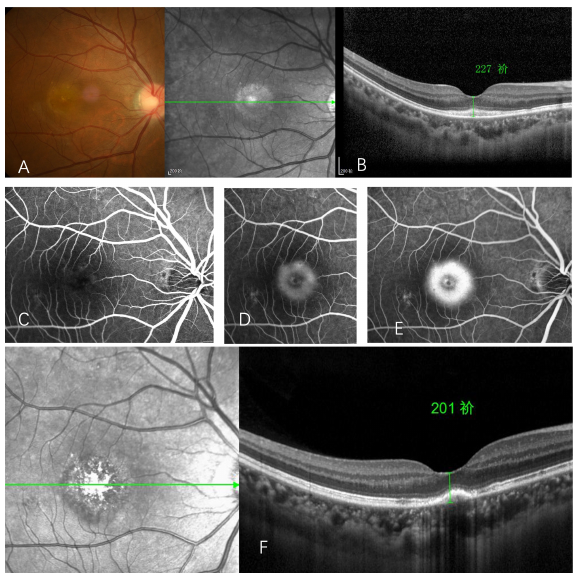
Figure 3. Acute idiopahtic maculopathy following inactivated COVID-19 vaccine administration. Fundus photography of a patient presented with sudden painless visual loss in the right eye one week following the first dose of inactivated COVID-19 vaccine showing subretinal foveal yellowish-white lesion ( A ), corresponding to hyperplasia of the retinal pigment epithelium (RPE) and disruption of the ellipsoid layer showed in OCT ( B ), and late staining in the late phase of FA ( C – E ). Resolution of RPE hyperplasia was noted at the 4-week follow-up ( F